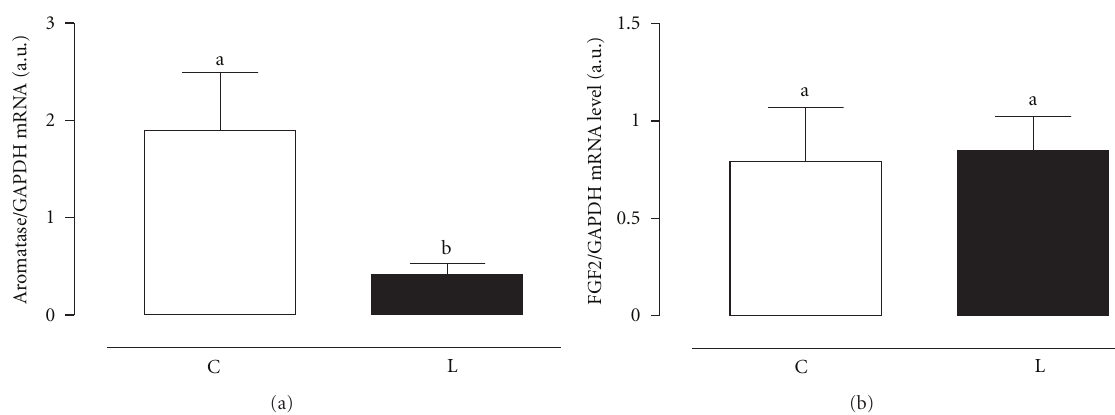
Figure 2: Gene expression of FGF2 (a) and aromatase (b) in the human hyperplasic prostate tissue after leptin treatment, 50 ng/mL, (Leptin) or not (Control) for 3 hours. GAPDH was used as an internal control. Primer sequences are listed in the Table 1. Data are represented as mean ± SEM of 15 individuals. Di ff erent letters mean statistically significance.